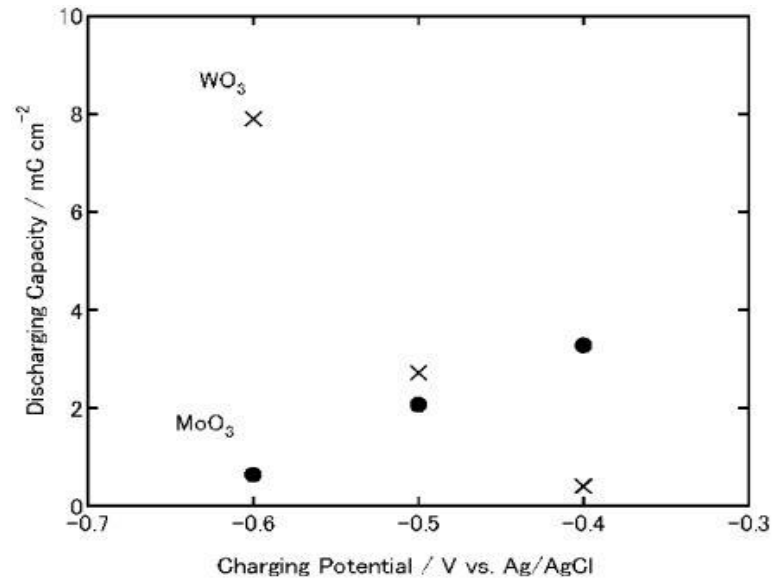
Figure 8. Discharging capacities of MoO coatings were discharged electrochemically at 1μA (cut-off potential = −0.1V vs. Ag|AgCl) after electrochemical charging (Figure 3) in 3 wt. % NaCl aqueous solution (pH 5) [23]. Reproduced with permission from Elsevier, ©